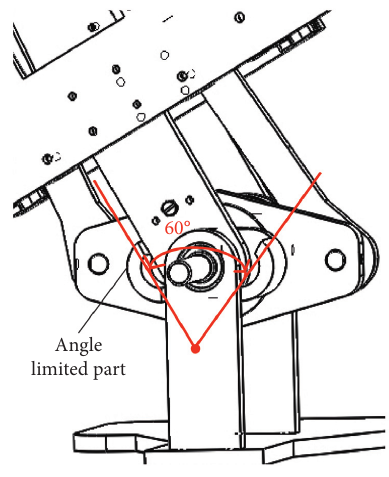
Figure 4: Angle limited